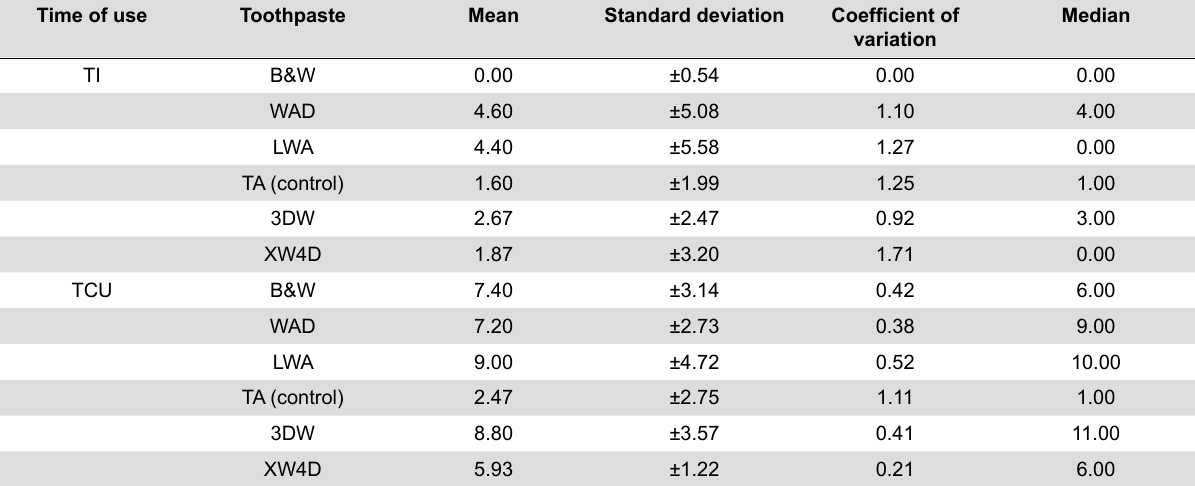
use (xΔSGUTI=2.52 and xΔSGUTCU=6.80) for all whitening toothpastes. However, the control